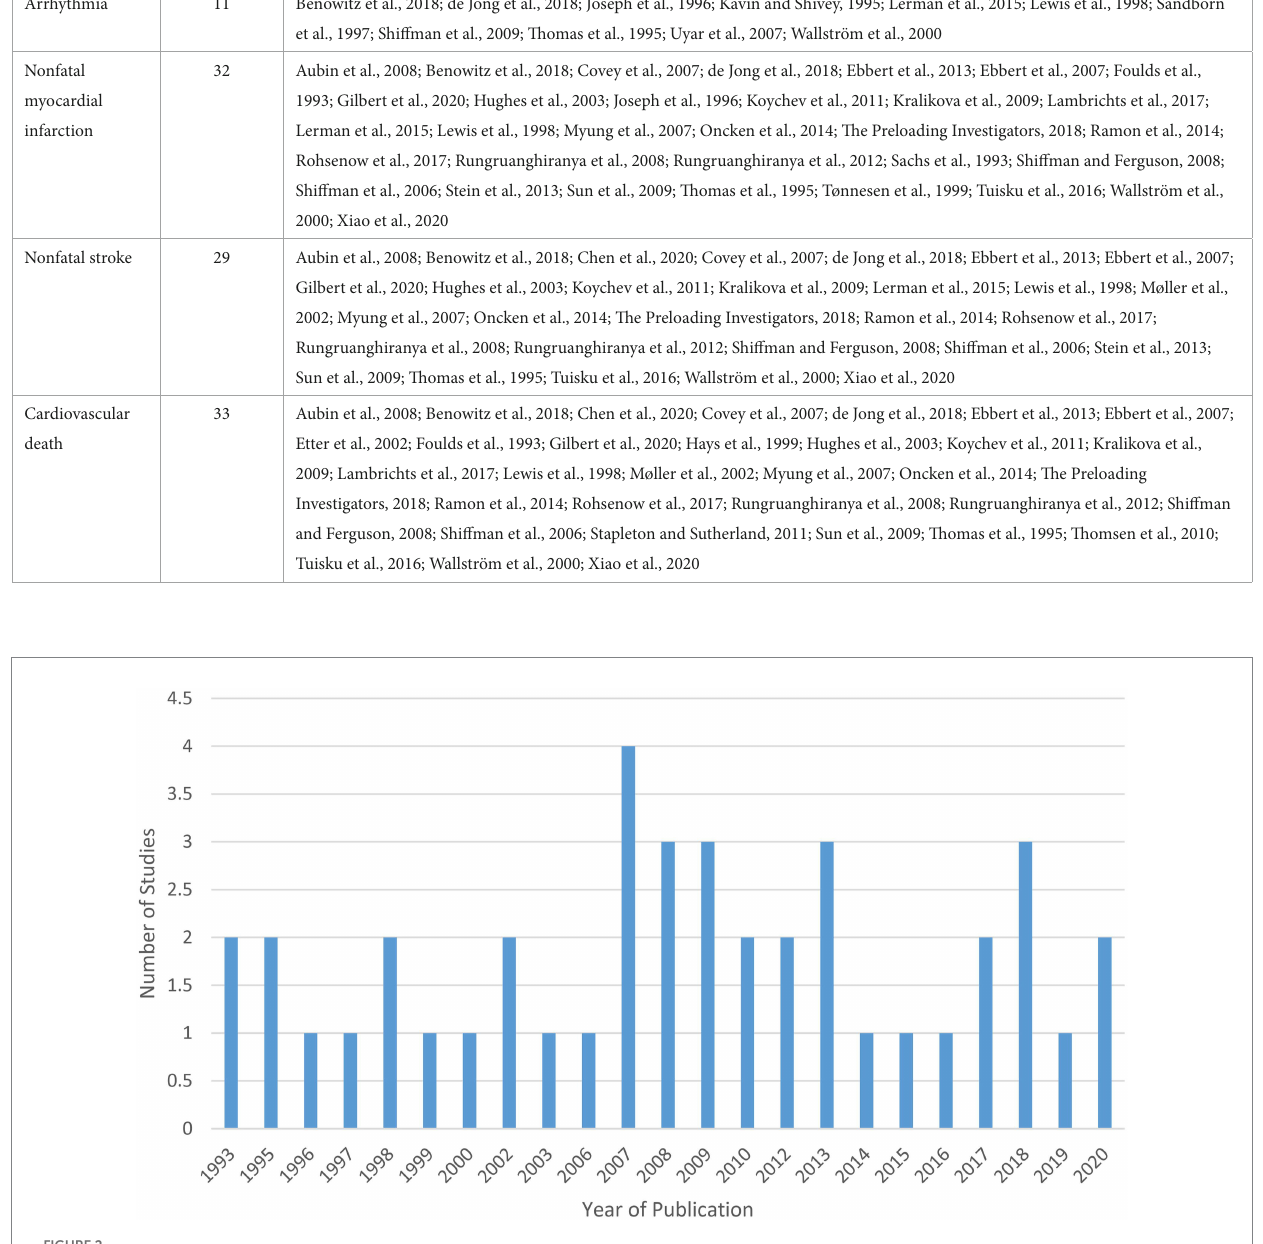
FIGURE 2 Included studies by publication